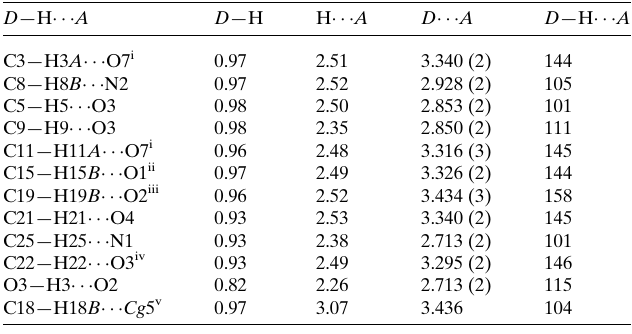
Table 1 Hydrogen-bond geometry (A˚ , (cid:2) ). Cg 5 is the centroid of the C20–C25 ring.